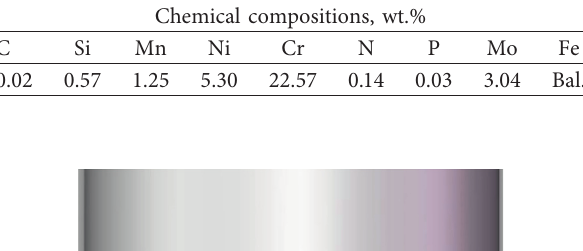
Table 1: Chemical compositions of 2205 DSS.